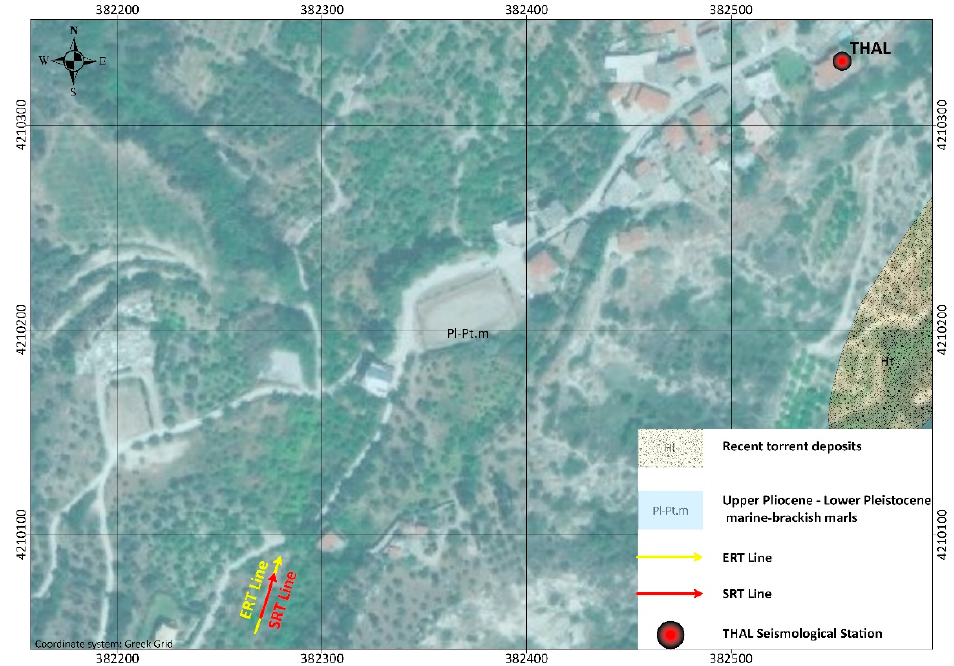
Figure 12. Location of the seismological station THAL and the geophysical measurements along with the geology of the area.